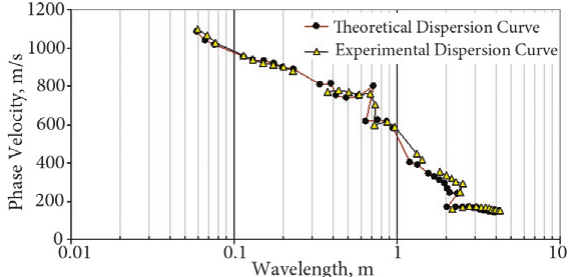
fig. 6. A typical experimental dispersion curve from a complete set of SASW tests on the pavement model compared to a theoretical dispersion curve from 3D wave propagation theory, which shows the variation of wavelength with different phase velocities